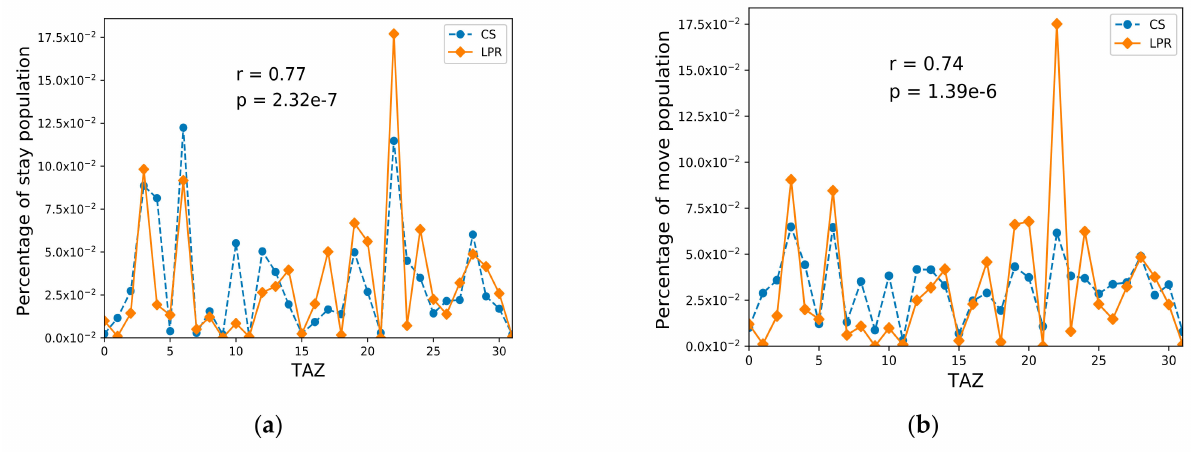
Figure 3. All-day population distributions with traffic analysis zone (TAZ) level. ( a ) All-day stay population distribution; ( b ) all-day move population